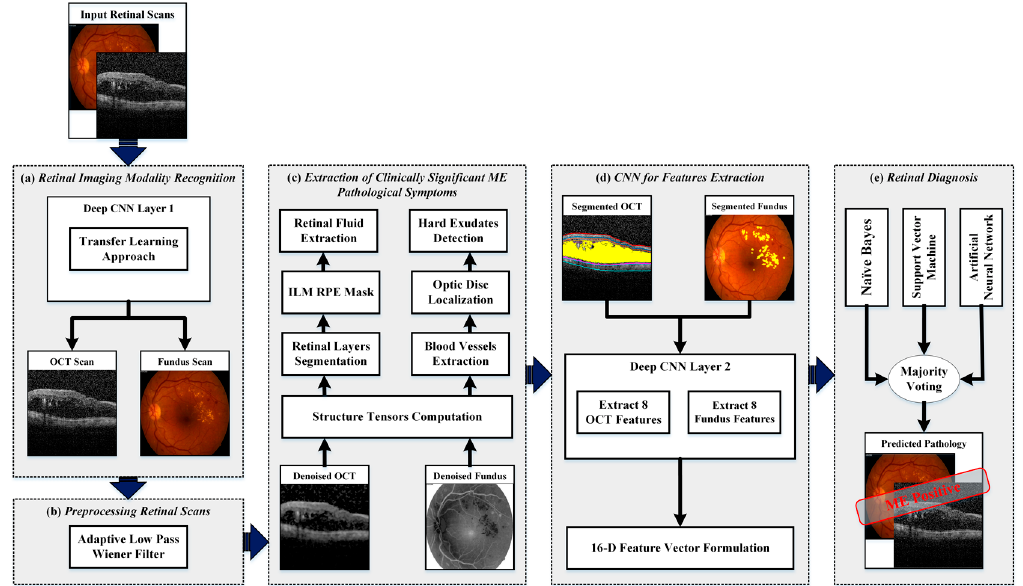
Figure 3. Proposed methodology for automated recognition and classification of healthy and macular edema (ME) affected eyes. ( a ) Retinal imaging modality recognition; ( b ) preprocessing retinal scans; ( c ) extraction of clinically significant ME pathological symptoms; ( d ) convolutional neural network (CNN) for feature extraction and ( e ) retinal diagnosis.